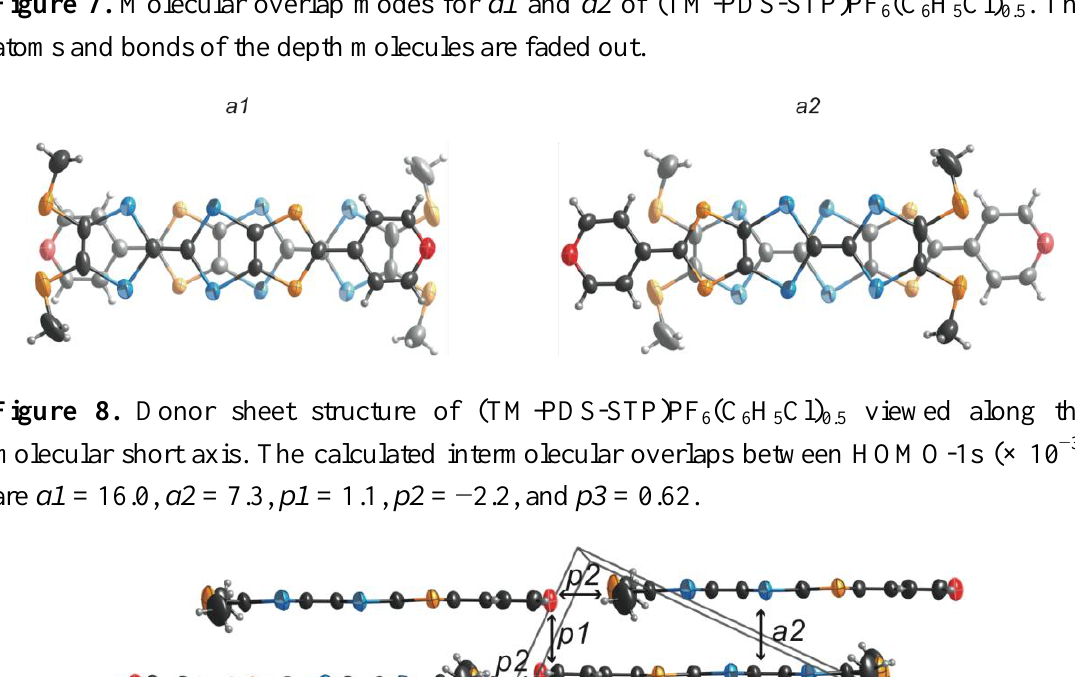
(C H Cl) . The 6 6 5 0.5